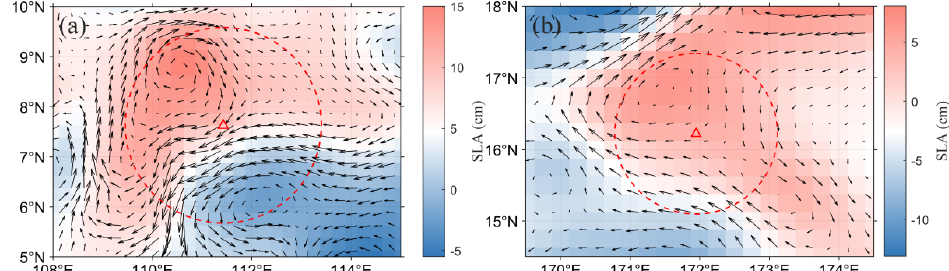
Figure 19. Two cases of irregular eddies in the META dataset in ( a ) the SF region on 14 January 2019, and ( b ) the SCS region on 28 February 2019, respectively. The red triangle is the calculated eddy center, and the dashed curves represent the circle corresponding to the eddy radius of the META dataset. Arrows indicate flow direction.